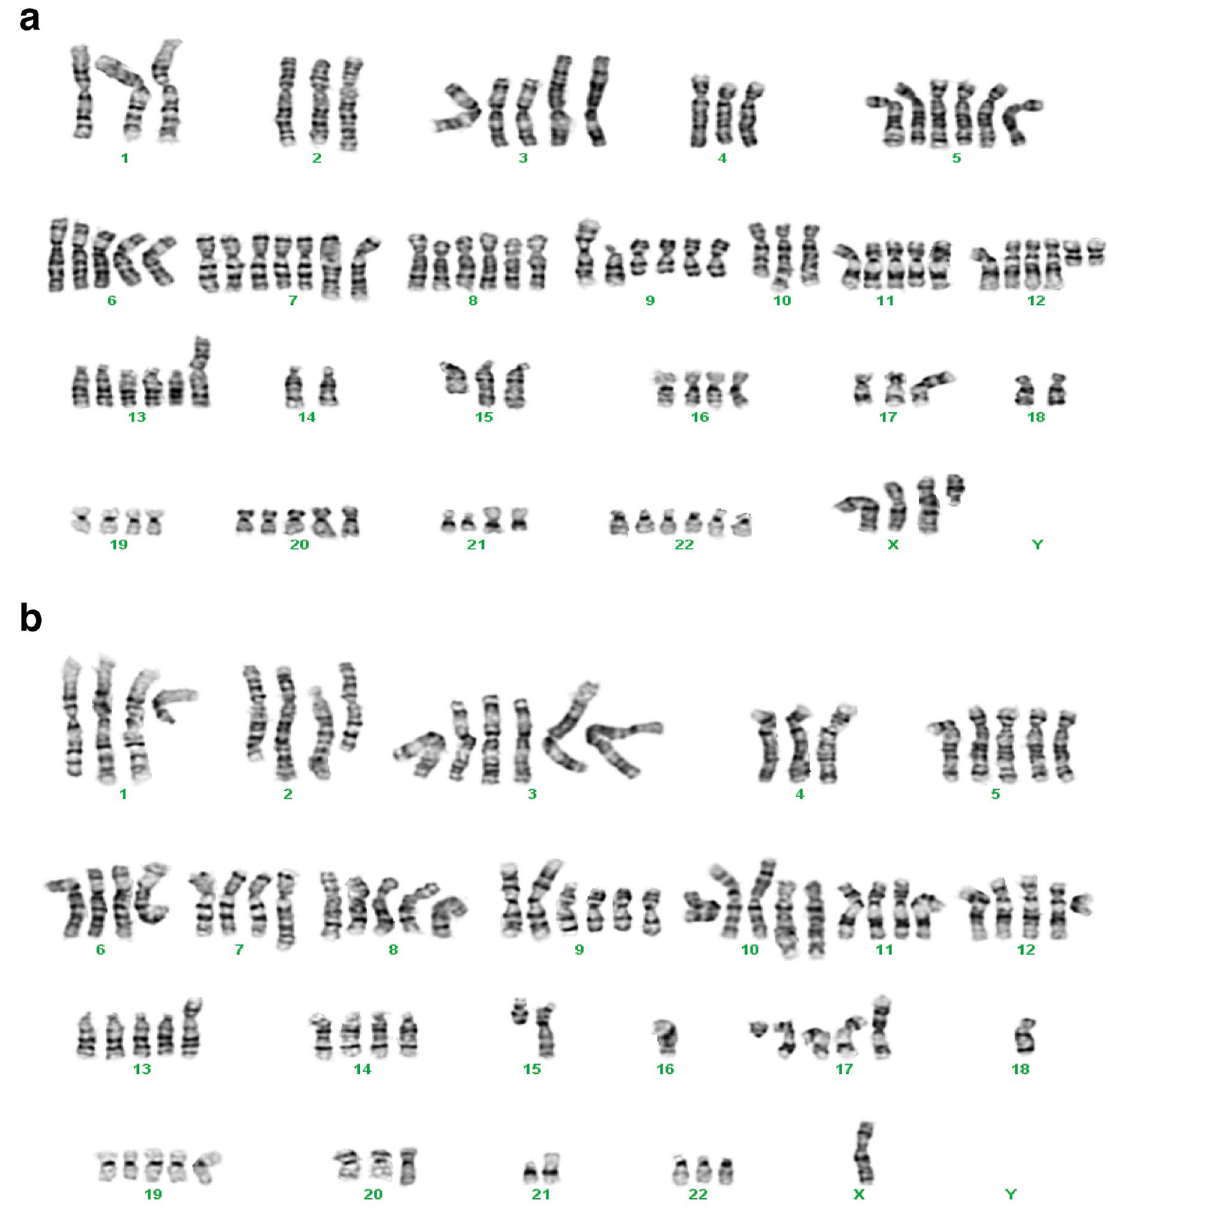
genome. Complex karyotyping can be characteristic of genetically unstable, highly aneuploid tumor